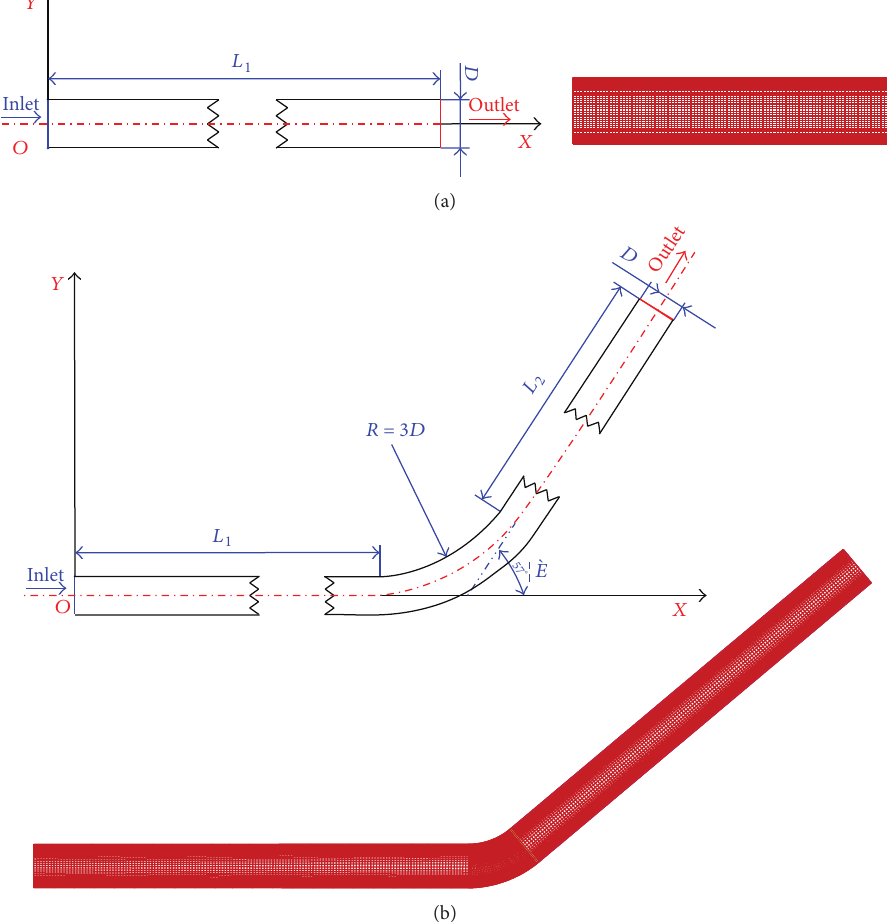
Figure2:Sketchofthegeometryandnumericalgridforcomputationaldomain:(a)straightpipe;(b)undulatingpipewithaninclinedupward